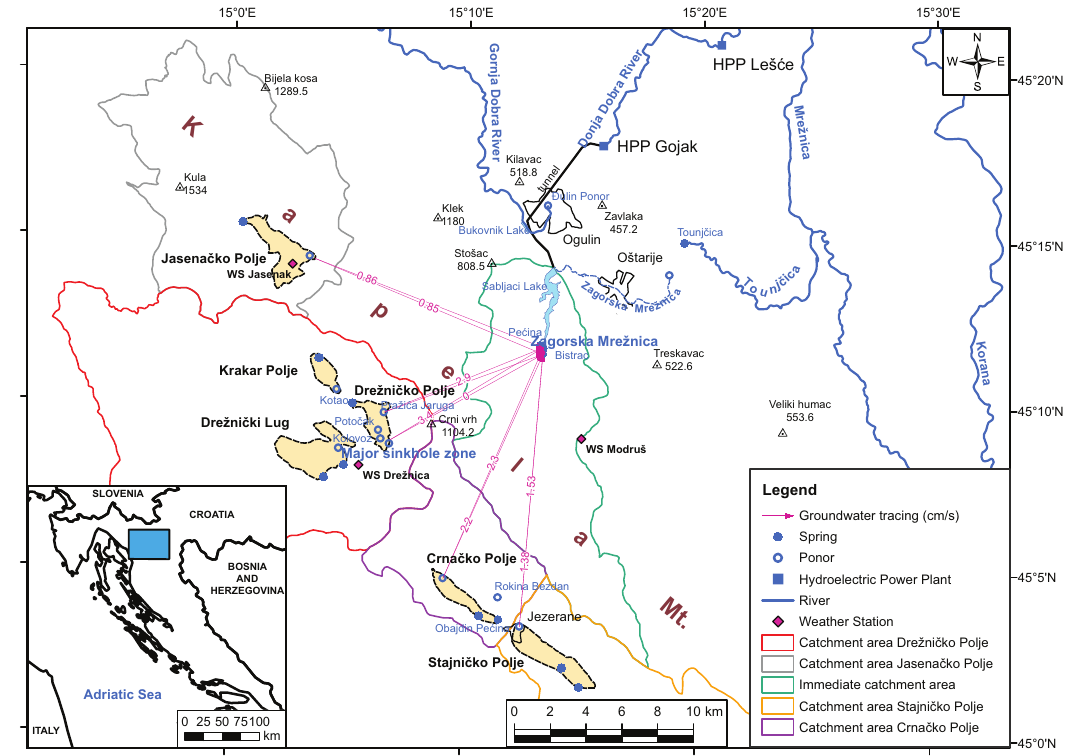
Figure 1. Location of the research area in Europe and in the local region, with the most important karst poljes, rivers, hydro-features and toponyms